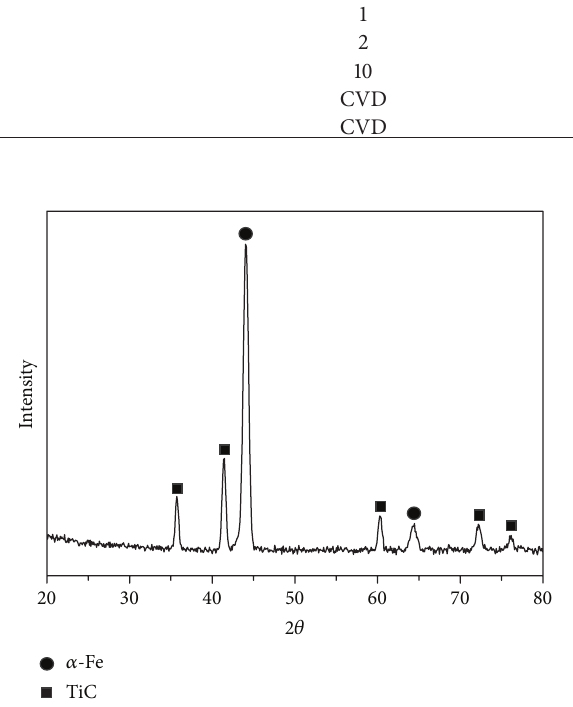
Figure 8: XRD spectrum of samples of dispersed iron with titanium-carbon nanostructures after treatment with 10 cycles of ALD reactions and sintered at 1100 ∘ C.